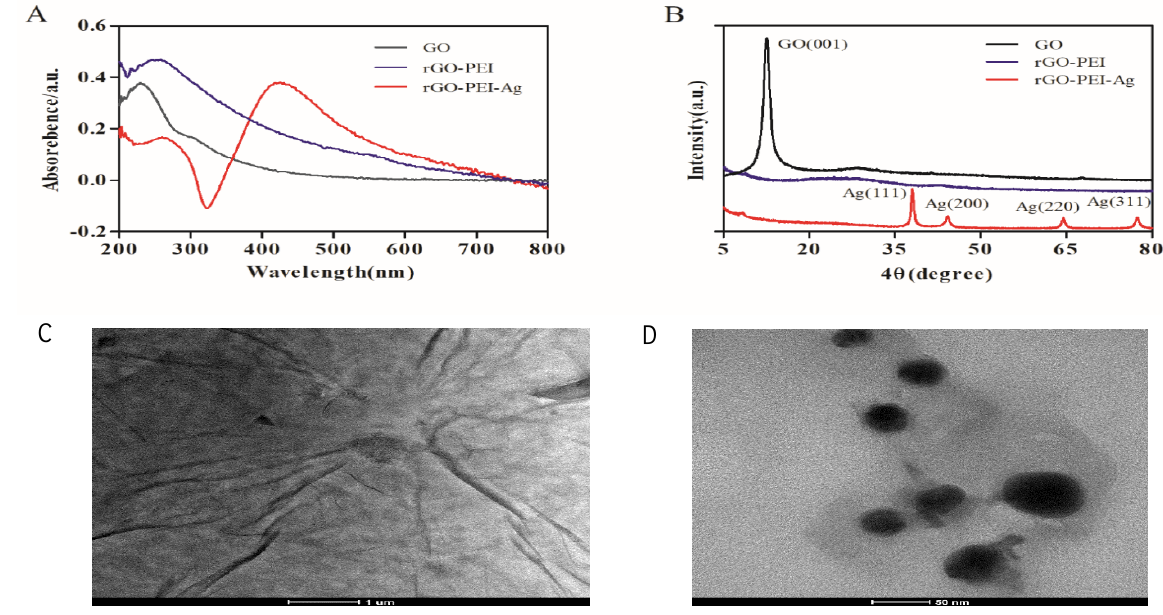
Figure 2. UV-Visible spectra ( A ) and XRD patterns ( B ) of GO, rGO-PEI and rGO-PEI-Ag; TEM image of GO ( C ) and rGO-PEI-Ag ( D ).